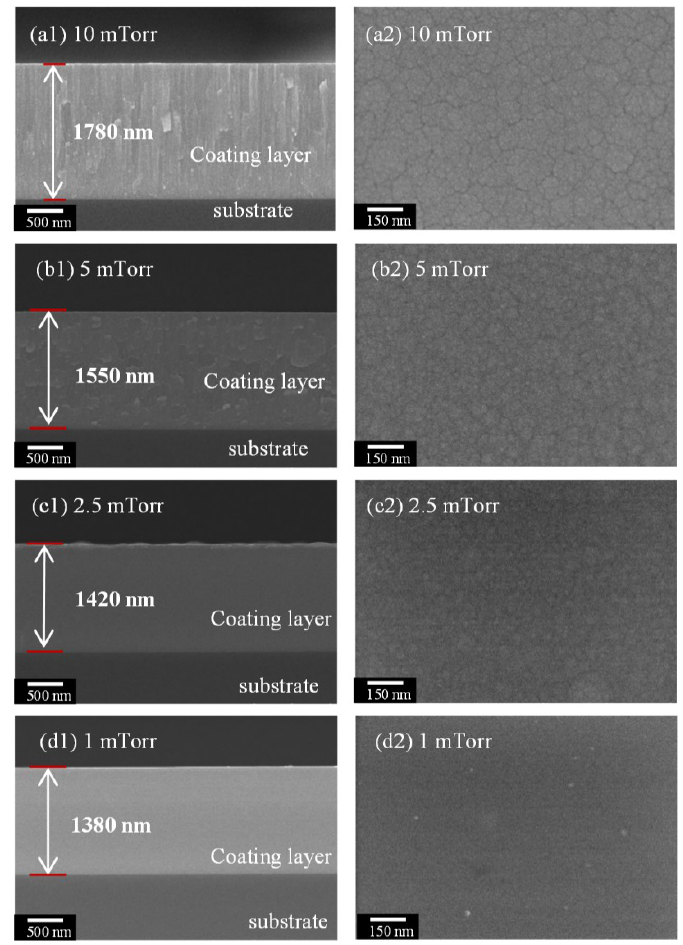
Figure 5. Cross-sectional and surface FE-SEM micrographs of the Mo–Si–N coatings deposited at various working pressures of ( a1 , a2 ) 10, ( b1 , b2 ) 5, ( c1 , c2 ) 2.5, and ( d1 , d2 ) 1 mTorr, retaining the N 2 gas flow ratio of 25%.